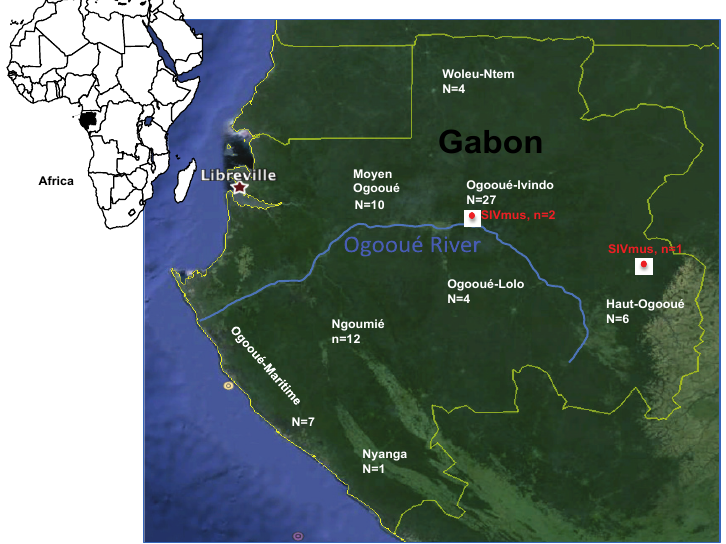
Figure 1. Geographical distribution of samples from moustached monkeys in Gabon. Haut-Ogooué (HO) n = 6, Moyen Ogooué (MO) n = 10, Ngounié (NG) n = 12, Nyanga (NY) n = 1, Ogooué Ivindo (OI) n = 27, Ogooué Lolo (OL) n = 4, Ogooué Maritime (OM) n = 7, Woleu-Ntem (WN) n = 4. Red points show the two sites where SIVmus positive animals were